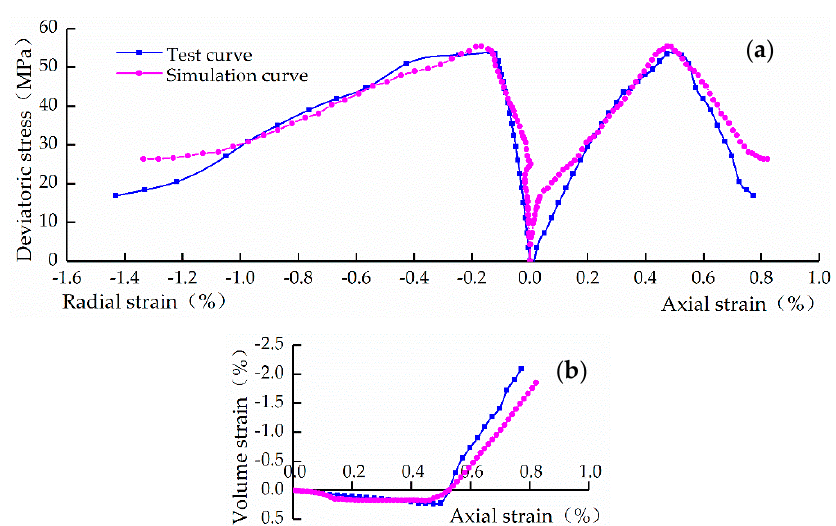
Figure 11. The simulation curve and test curve of ( a ) deviatoric stress vs. axial strain and radial strain and ( b ) volume strain vs. axial strain when the confining pressure is 10 MPa.